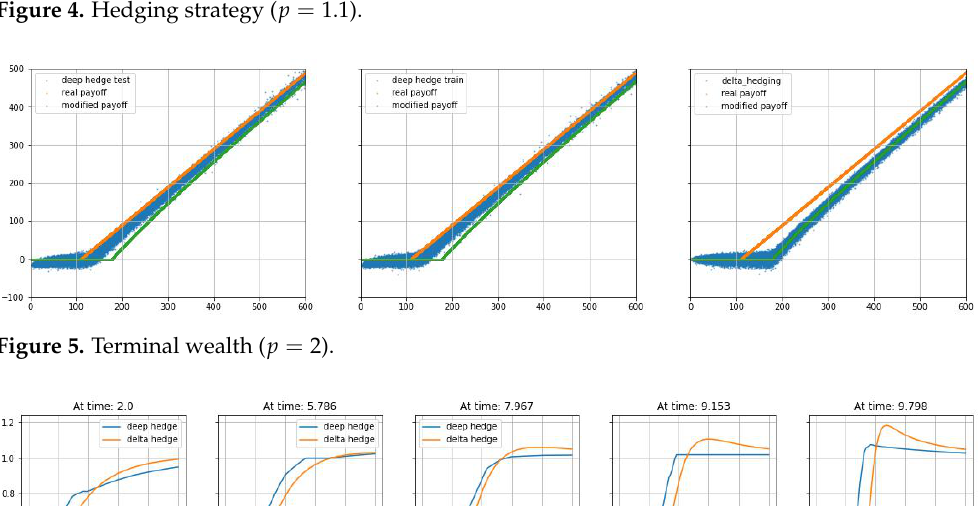
Figure 4. Hedging strategy ( p = 1.1).